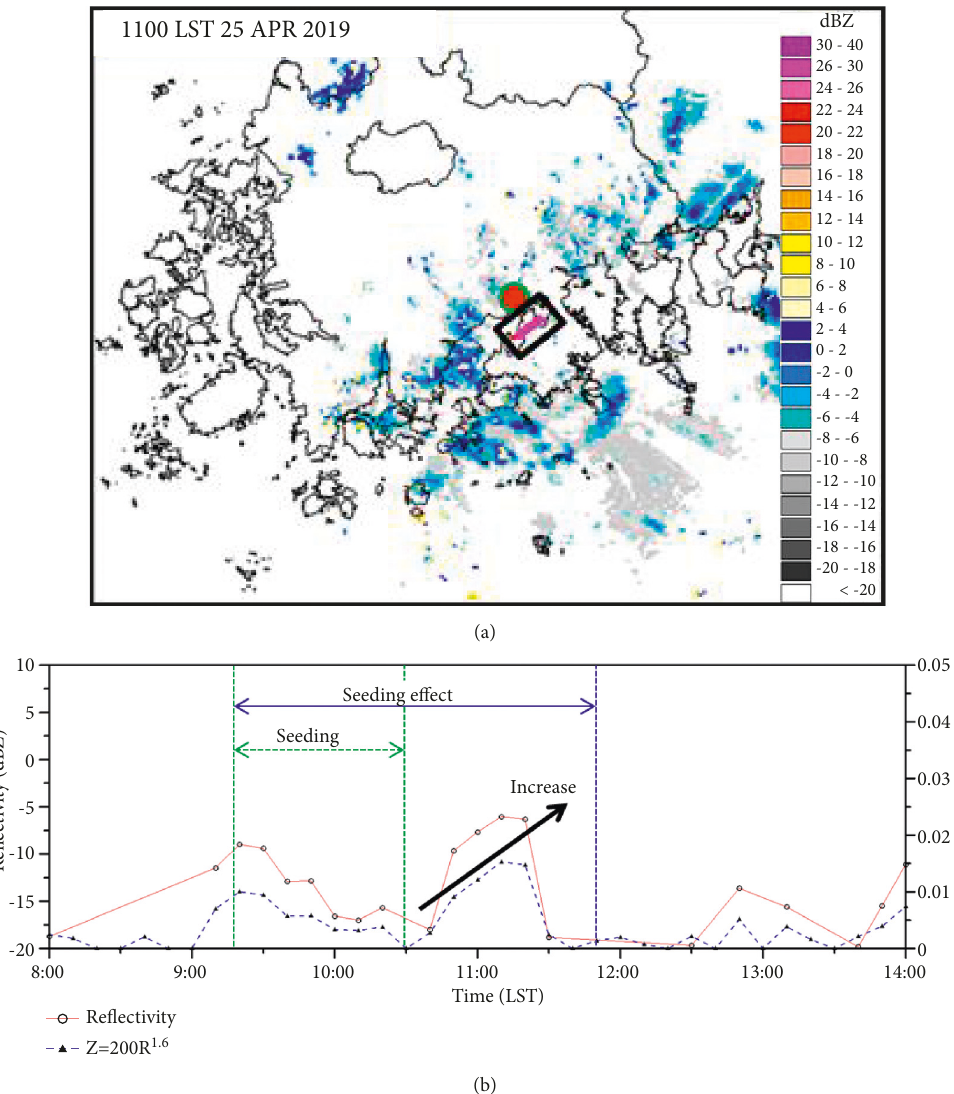
Figure 7: (a) Horizontal distribution of reflectivity at 1100 LST and (b) time series of reflectivity (red solid line with circle) and radar precipitation (blue dotted line with triangle) at BSWO (red point) from 0800 to 1400 LST on April 25,